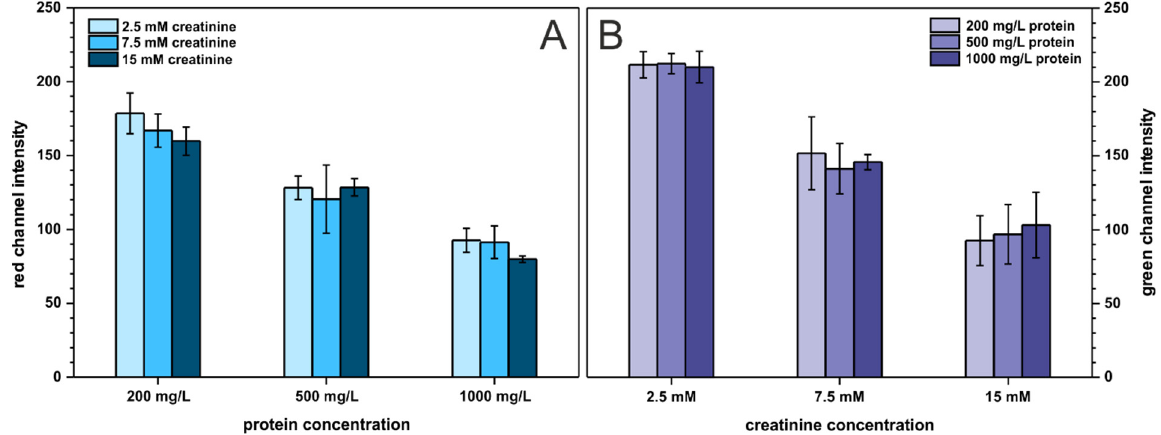
Figure 6. Cross-reactivity study. Bars in ( A ) represent the registered signal for protein determination with varying creatinine content, n = 3. Bars in ( B ) represent the registered signal for creatinine determination with varying protein content, n = 3.